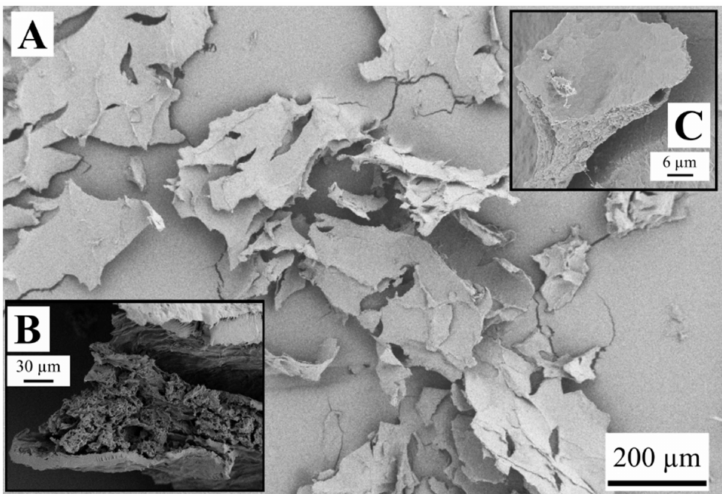
Figure 3. Structure of the sample FD-G-FR derived from 5 wt.% starch suspension and freeze-dried at sublimation pressure of 0.045 mbar ( A , C ) and 2.38 mbar ( B ).